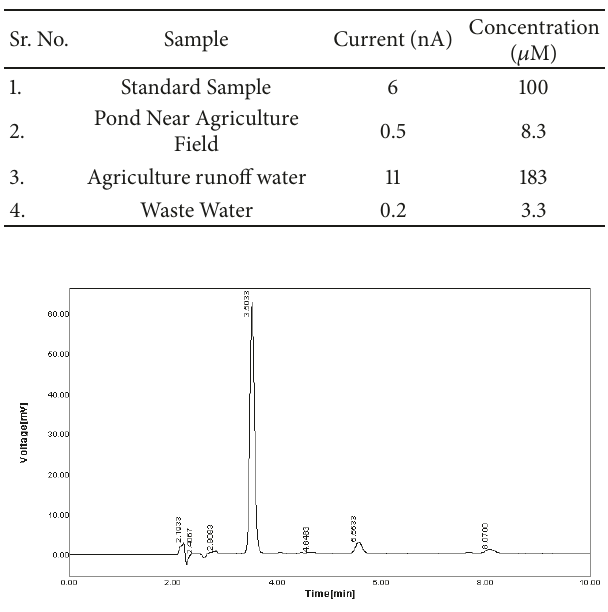
Figure 10: HPLC chromatogram of spiked water